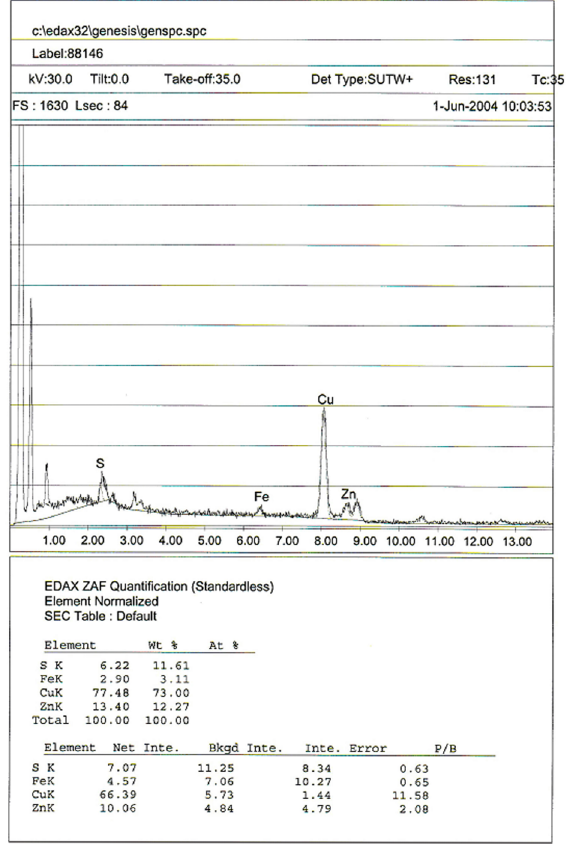
Figure 3. Energy spectrum of intracellular magnetic nanoparticle deposits in SMMC-7721